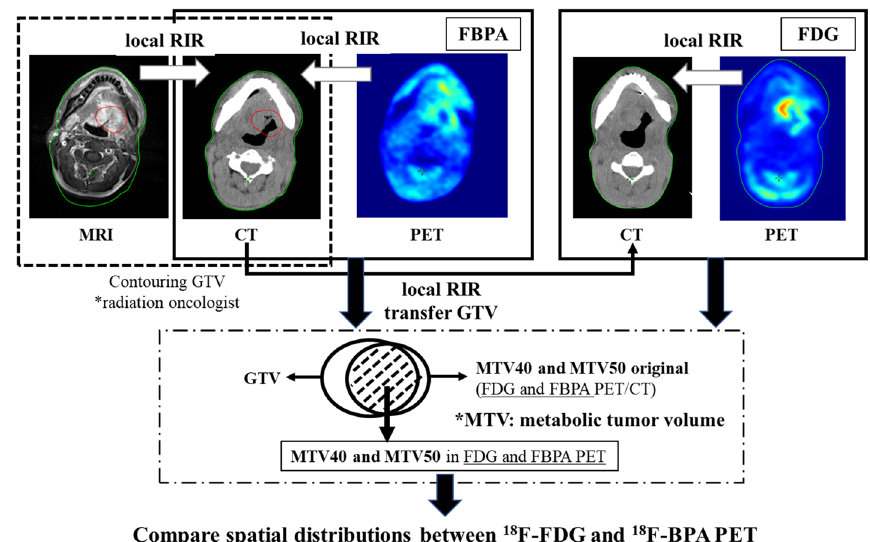
Fig. 2 The process of image registration and analysis incorporated in the MIM workflow function